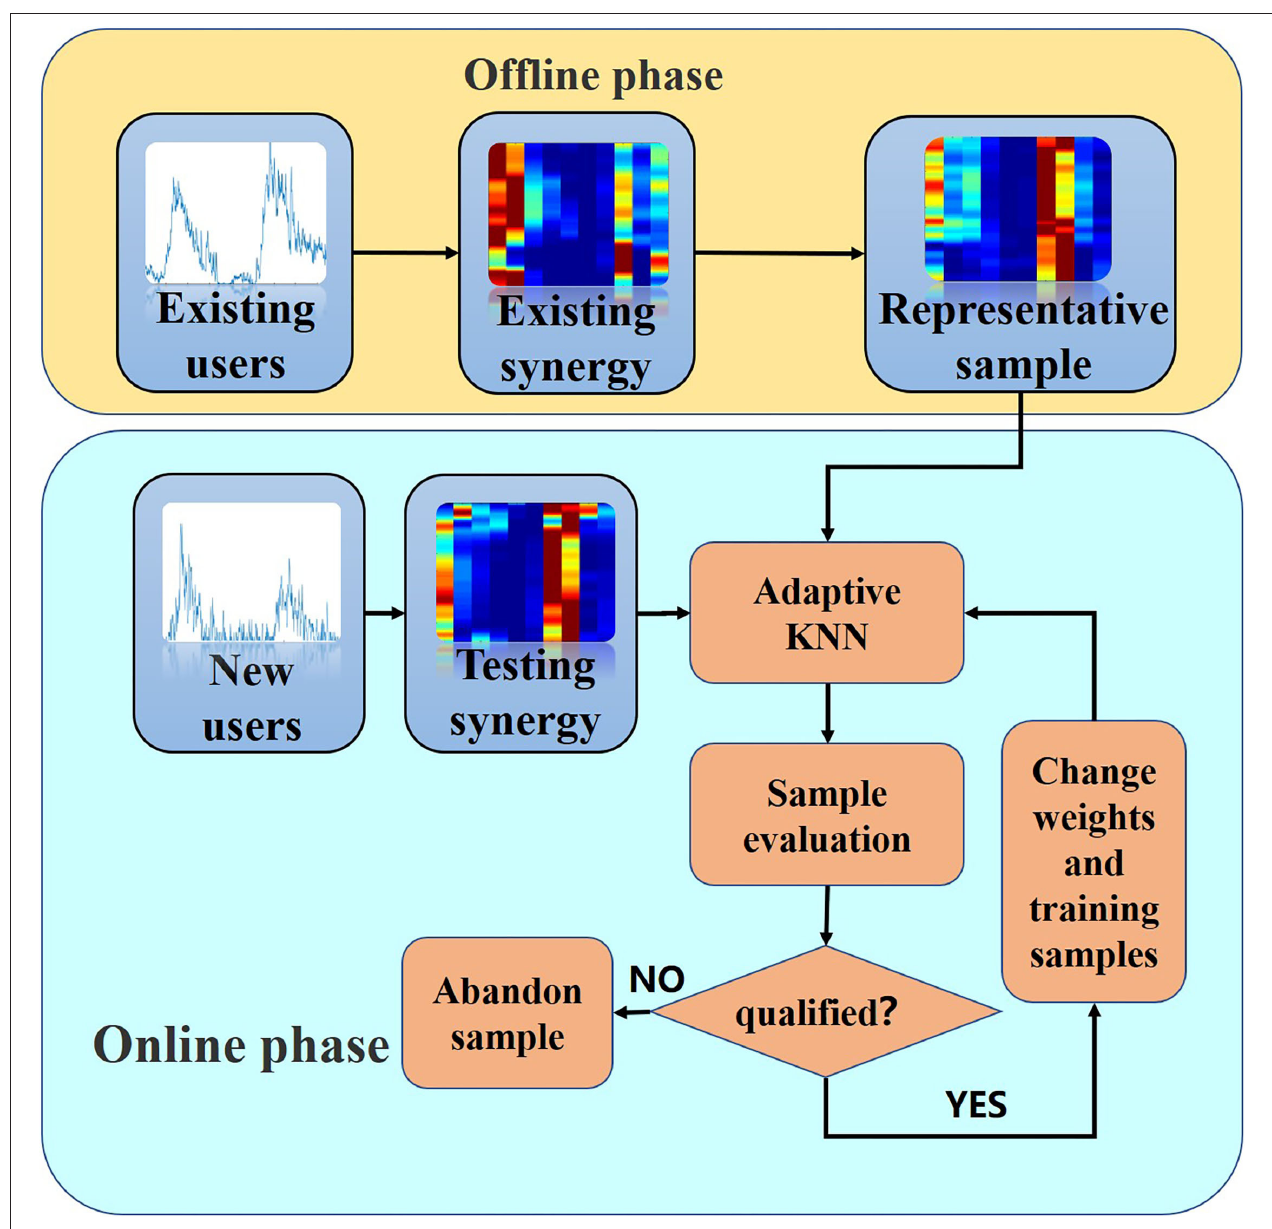
FIGURE 3 | The framework for user-independent gesture recognition.